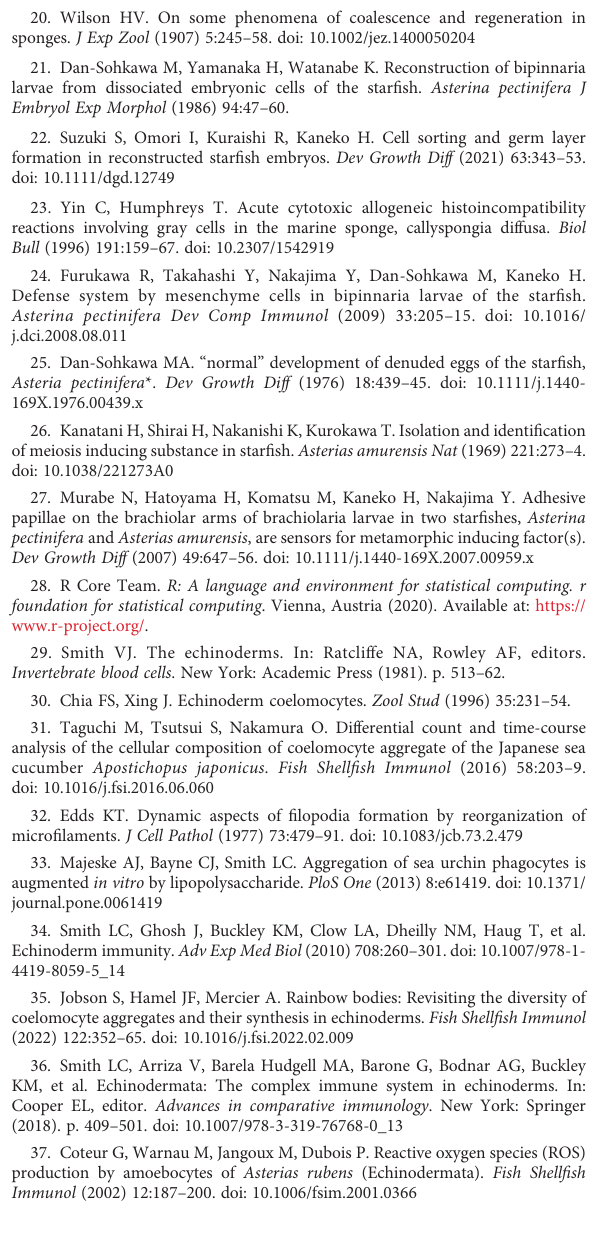
allorecognition response, the interspace of each coelomocyte that phagocytosed the bacteria was fi lled with pseudopodia, indicating that the coelomocytes did not fuse with each other but phagocytosed the bacteria individually. Scale bar: 2 µm. SUPPLEMENTARY FIGURE 4 Body length of chimeric individuals in each developmental stage. Body length (long diameter) of reconstructed chimera was measured and plotted. No signi fi cant differences were detected in each developmental stage according to analysis of variance (ANOVA)